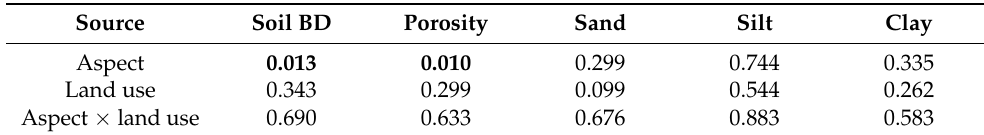
Table 2. Interactive effects of aspect and land use on soil bulk density (BD), porosity, sand, silt, and